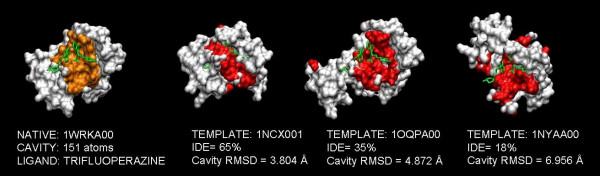
Ligand binding in models at a range of seq.id. levels Binding of trifluoroperazine to the N-terminal domain of cardiac troponin C (PDB code: 1WRK). The experimental structure of the complex is shown on the left, with the two trifluoroperazine molecules shown in green and the cleft atoms highlighted in orange. The latter are shown in red in different models of the protein, while the trifluoroperazine molecules (green colour) are kept in the same orientation as in the experimental structure. We can see that in this case, even for good seq.id., protein-ligand contacts are poorly reproduced.